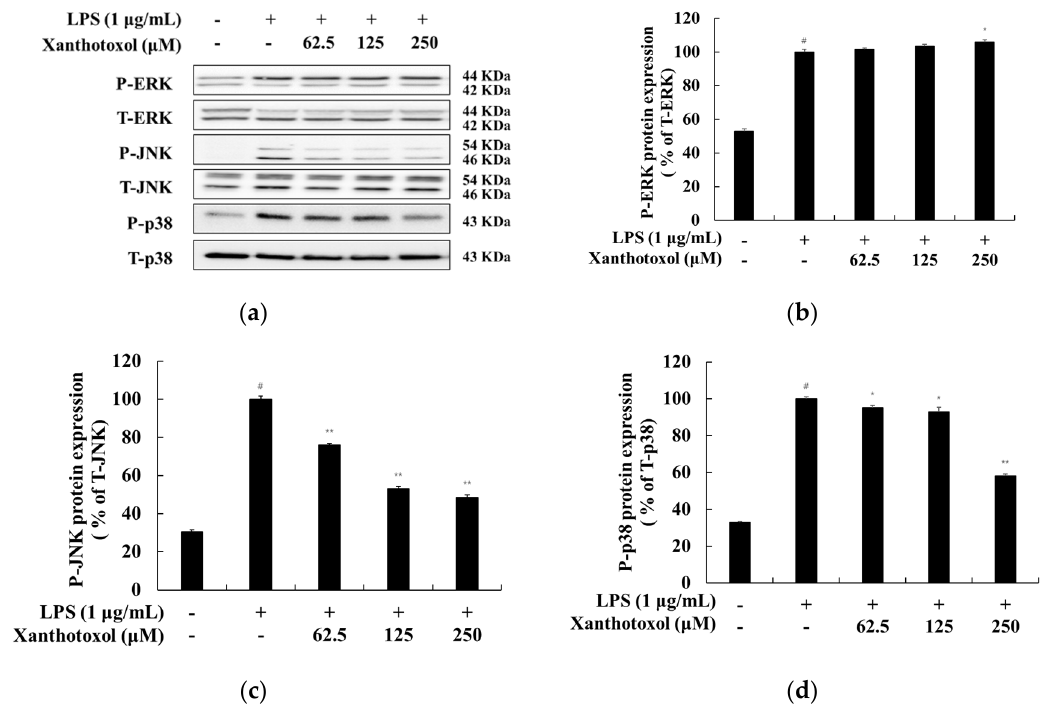
Figure 6. Effect of xanthotoxol on phosphorylation level of MAPK in LPS-induced RAW 264.7 cells. The cells were treated with xanthotoxol (62.5, 125, and 250 μ M) and LPS (1 μ g/mL) for 20 min. ( a ) Western blotting results, and protein expression of ( b ) P-ERK/T-ERK, ( c ) P-JNK/T-JNK, and ( d ) P- p38/T-p38. β -actin was used as a loading control. The results are presented as the mean ± SD from three independent measurements using the Image J. # p < 0.01 vs. untreated control group. * p < 0.05 and ** p < 0.01 vs. LPS